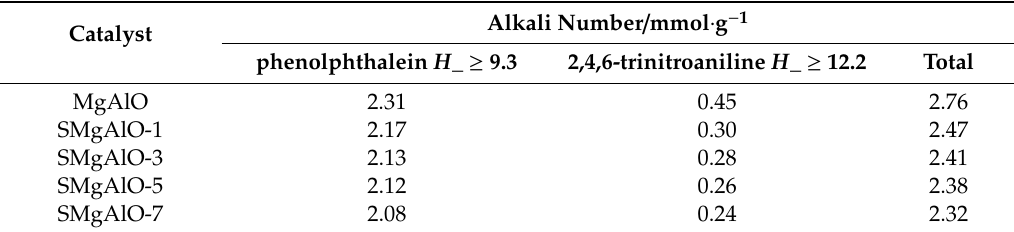
Table 3. Hammett